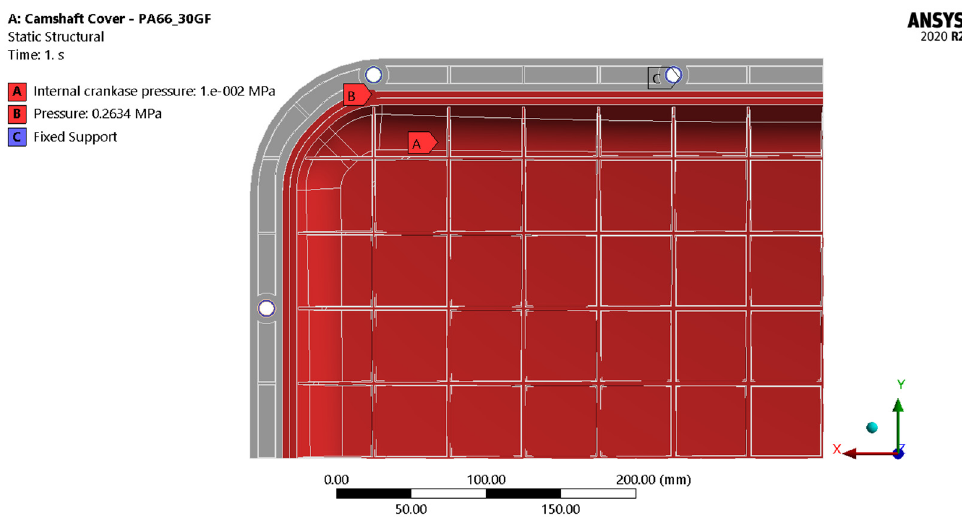
Figure 5. Loads and constraints condition.